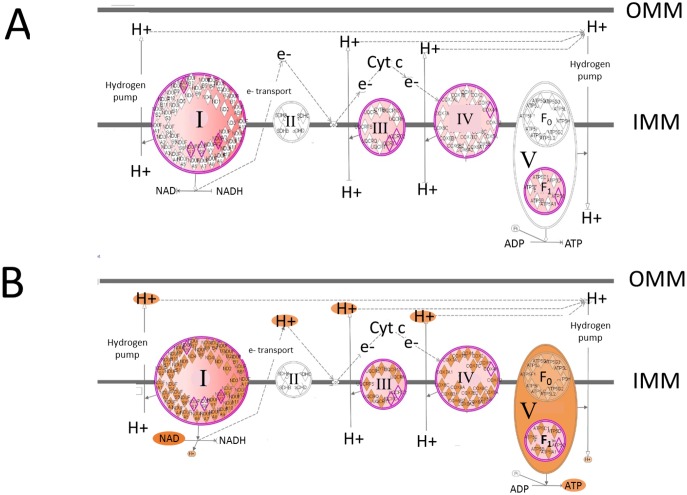
The canonical pathway of oxidative phosphorylation.The canonical pathway of oxidative phosphorylation (generated by the IPA program) showing; A) The differential expression of proteins in breast muscle associated with the electron transport chain on (Complex I, II, III, IV, and V) that were up-regulated (outlined in pink) in the high feed efficiency phenotype. Pumping of hydrogen ions (H+) creates a proton motive force between the inner (IMM) and outer (OMM) mitochondrial membranes that is used to drive ATP synthesis B) Using the molecule activity predictor function of IPA for the oxidative phosphorylation pathway, the results indicate that Complex I, III, and IV, and V in breast muscle are predicted to have greater activity (indicated by the orange color) in the high compared to the low FE phenotype.